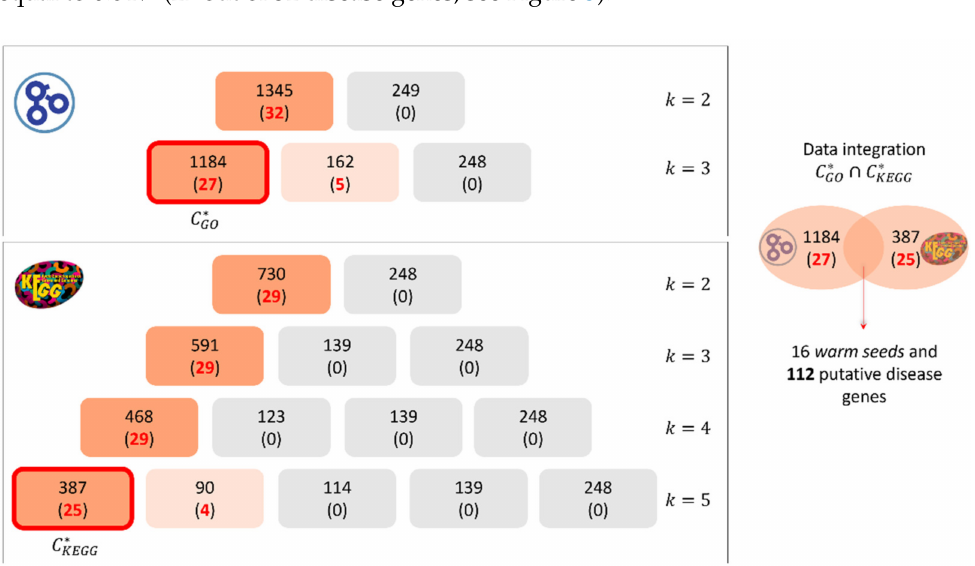
Figure 3. Clustering process applied to the disease amino acid metabolism inborn errors using GO-BP annotations (top panel) and KEGG pathways (bottom panel). On the right, the procedure of data integration and the identification of putative disease genes are